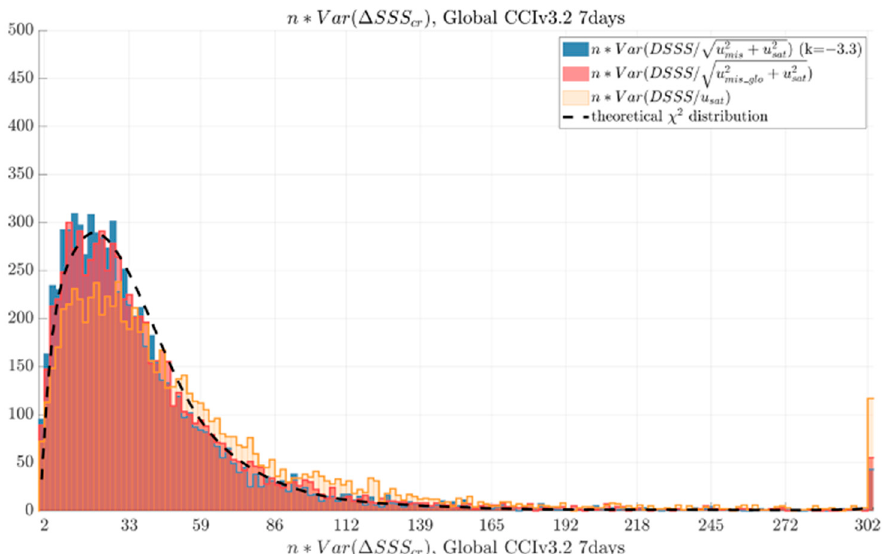
Figure 7. Histograms (bar graph) of number of points multiplied by variance in the pixels shown in Figure 6: (a) (orange), (c) (red) and (d) (blue). Points above 300 are grouped in one single class. This histogram is expected to follow a Chi2 distribution (dashed line) if Equation (1) holds for each pixel of the